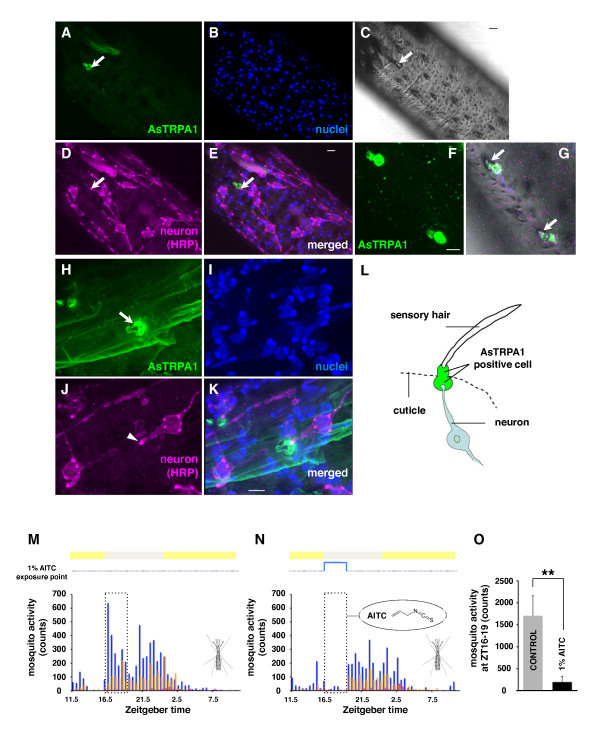
Mosquito TRPA1 is a candidate thermo-sensing protein for host-seeking behavior. (A-L) AsTRPA1 (+) cells (green) are present along the whole proboscis and in association with sensory neurons (magenta: HRP-positive neuron, D and J). Note that some sensilla contain AsTRPA1 (+) signals (A, F, and H). All bars: 5 μm. (M-O) TRPA1-activating agent (AITC) disturbs the selected host-seeking behavior. Female mosquitoes were exposed to 1% (v/v) AITC at ZT16-19. Note that volatile AITC reduces the selected host-seeking behavior compared to controls (**p < 0.01, t-test; mean ± SD, n = 5).